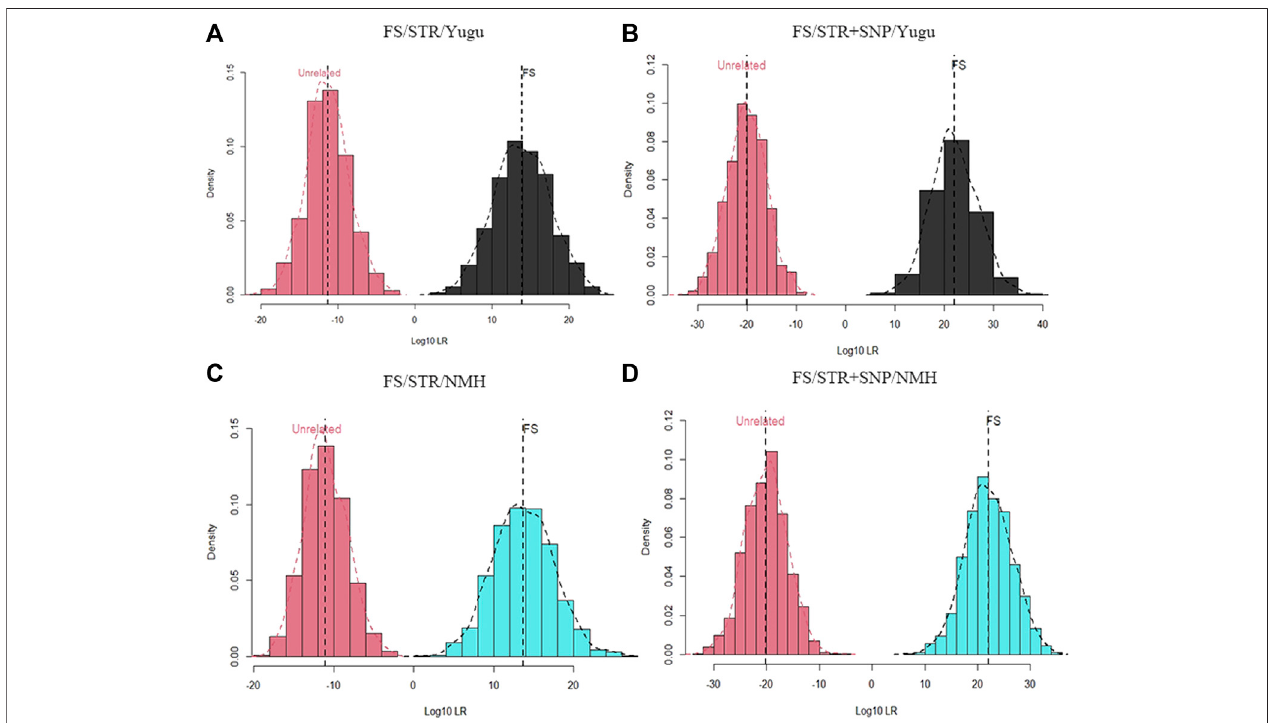
FIGURE4| Log 10 LRdistributionplotsobtainedfrom1000simulationsofrelationshiptestsbetweenfullsiblingsandunrelatedindividuals. (A) Log 10 LRdistributions whenonlyusing54A-STRlocitodistinguishfullsiblingsfromunrelatedindividualsintheYuguethnicgroup; (B) Log 10 LRdistributionswhenusing54A-STRlociand133 iiSNPs to distinguish full siblings from unrelated individuals in the Yugu ethnic group; (C) Log 10 LR distributions when only using 54 A-STR loci to distinguish full siblings from unrelated individuals in the NMH population; (D) Log 10 LR distributions when using 54 A-STR loci and 133 iiSNPs to distinguish full siblings from unrelated individuals in the NMH